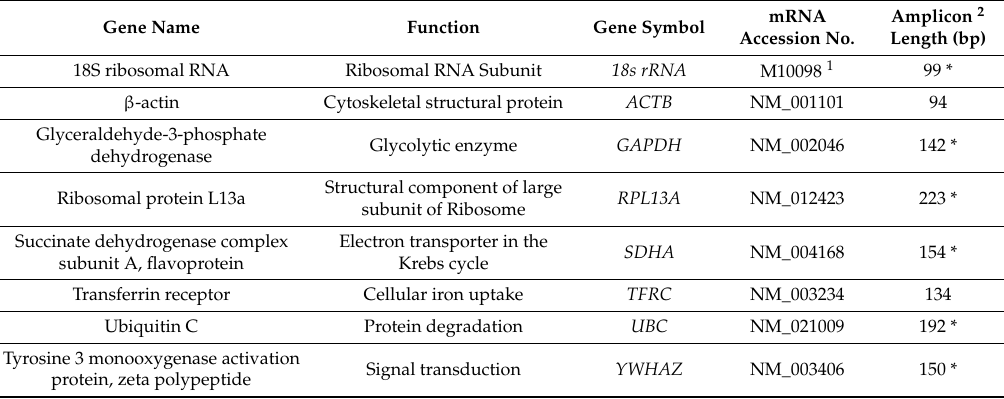
Table 2. List of the housekeeping genes evaluated as candidate reference genes during the first phase.